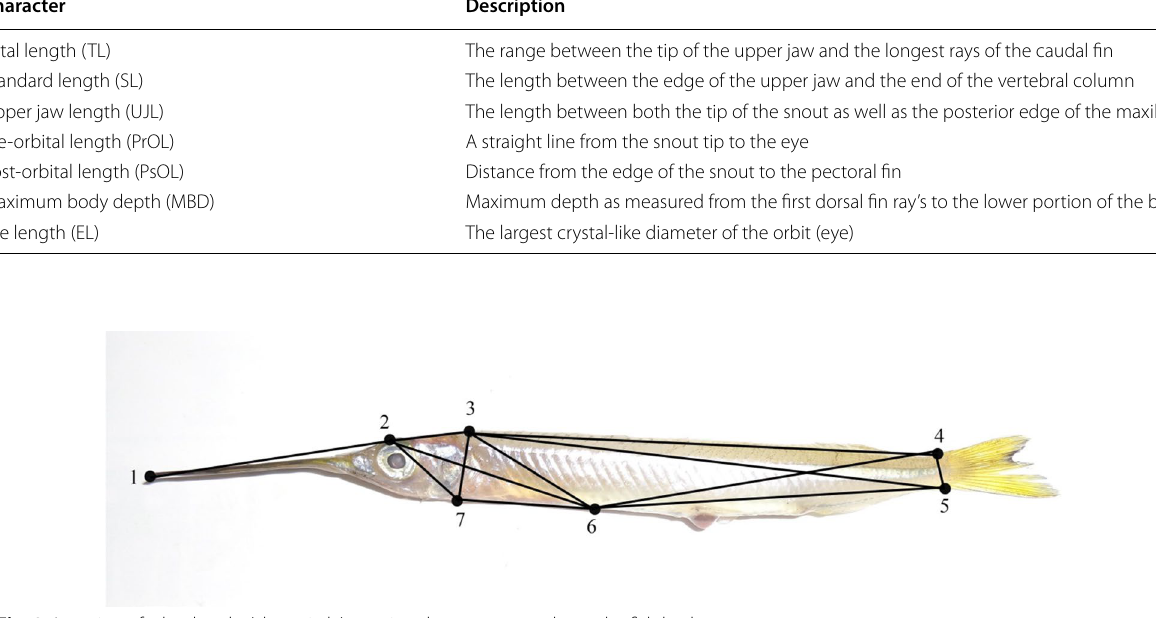
Fig. 3 Location of 7 landmarks (close circle) creating the truss-networks on the fish